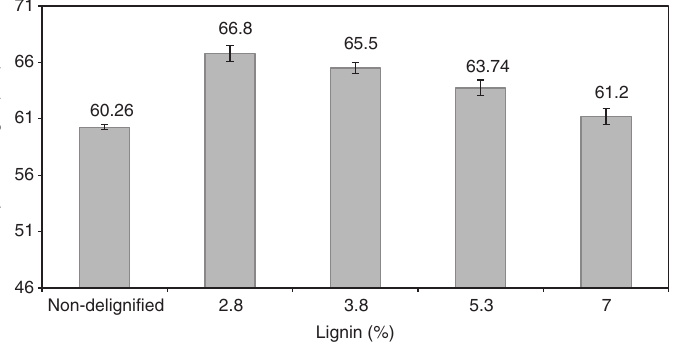
Figure 4: Influence of OCC fiber characteristics on the impact strength of OCC fiber/polypropylene composites.